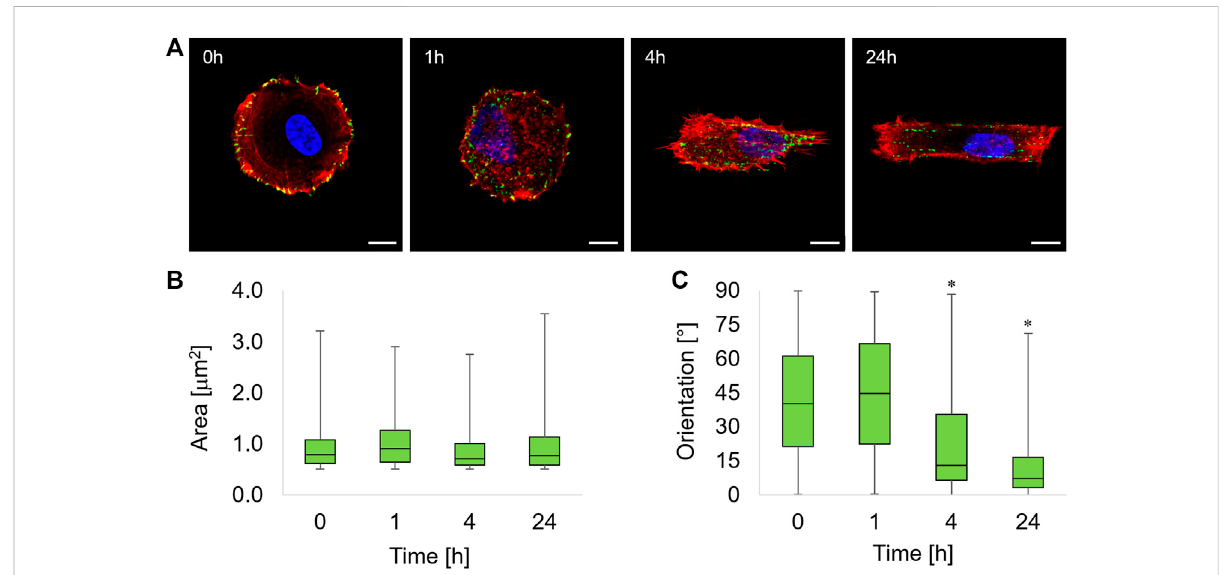
FIGURE 2 (A) Immuno fl uorescence images of ASC52telo cells cultivated on the fl at micropatterned pDR1m substrate (0 h) or on pDR1m displaying the topographic pattern 1, 4, or 24 h after the inscription. Nuclei (DAPI) are in blue, FAs (paxillin) are in green, and actin (phalloidin) is in red. Bar is 10 μ m. Box-and-whiskersplotoftheFAarea (B) andFAorientation (C) .Theasterisksindicatethatthemedianvalueofthedistributionissigni fi cantlydifferent from 45 ° .